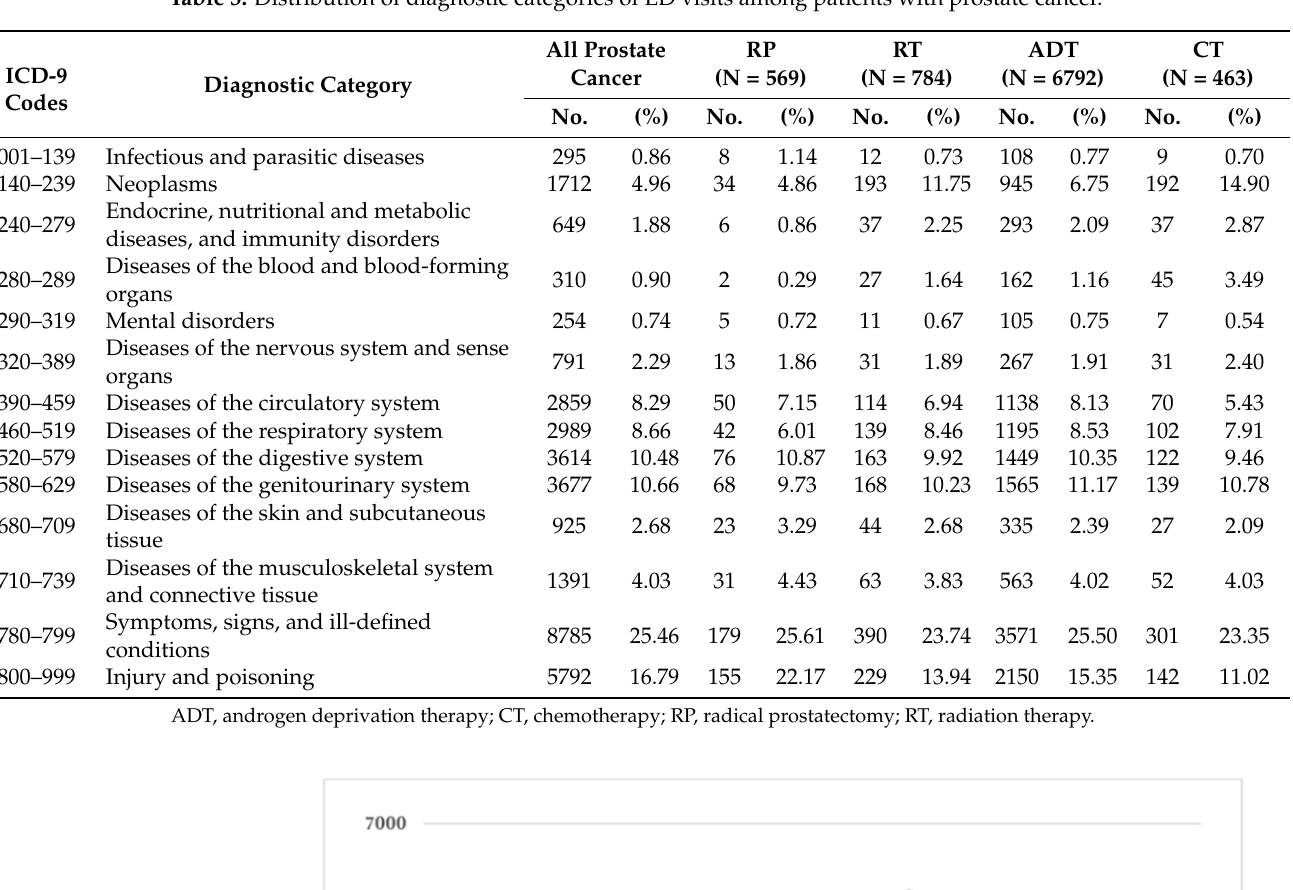
To the best of our knowledge, this is the first large, nationwide, population-based study to evaluate the medical utilization of the ED among patients with PCa in Taiwan. A total of 18,728 patients with PCa were enrolled in this study from the RCIPD between Figure 2. The monthly ED visits of prostate cancer patients from January 1997 to December 2013. 1997 and 2013. Across all study subjects, 74,057 ED visits were recorded, with an increasing trend in the number of visits during the study period. The overall IR for ED visits was Table 2. Utilization of emergency department according to different treatment of prostate cancer. 822 per 1000 people/year, with higher IRs noted for the RT and CT groups. The mean medical expenditure was TWD 3779.8, with the highest expenditure reported for the CT group. The three most common medical illnesses diagnosed among patients with PCa during ED visits were injury/poisoning (16.79%), genitourinary disorders (10.66%), and digestive disorders